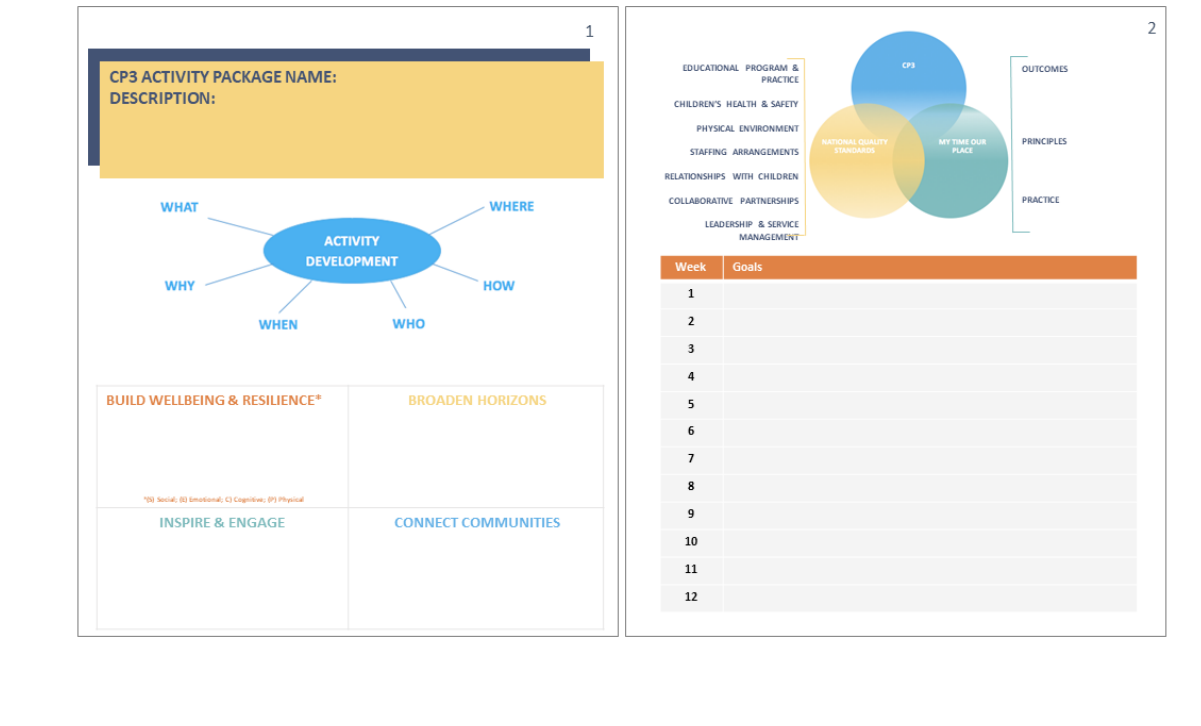
Additional Program